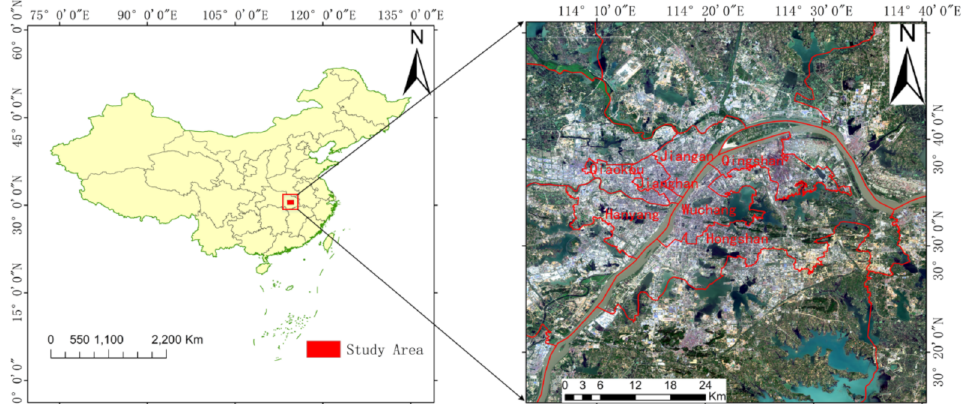
Figure 2. Location of the main urban area and surrounding areas of Wuhan, China ( left ); Sentinel-2 image (red–green–blue composite) and the boundary of the six districts in the main urban area of Wuhan ( right